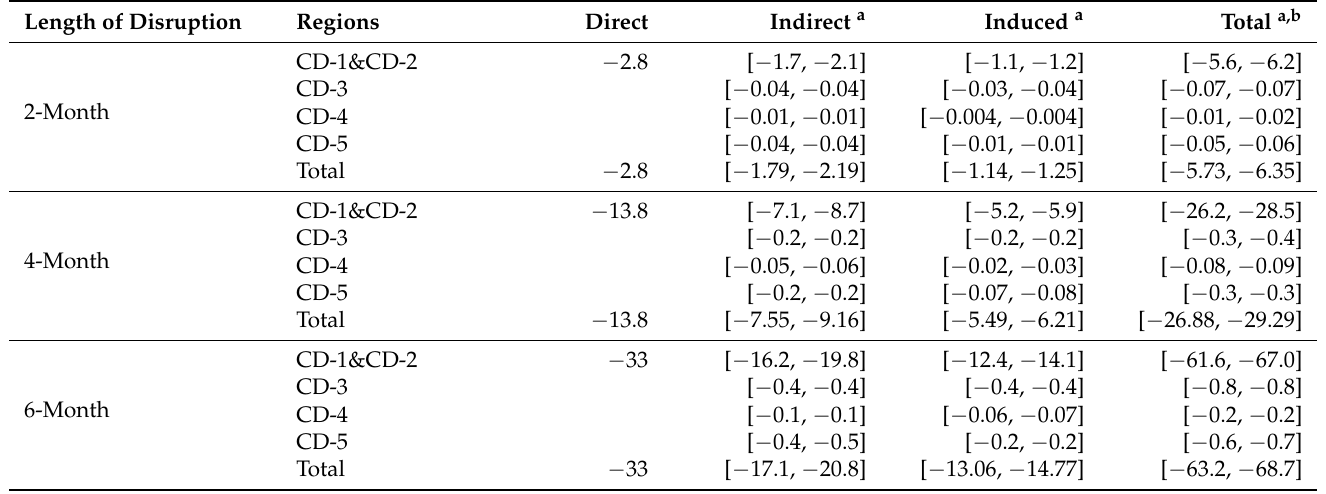
Table 10. Impact on decrease in value-added under different length of water transportation disruption ($